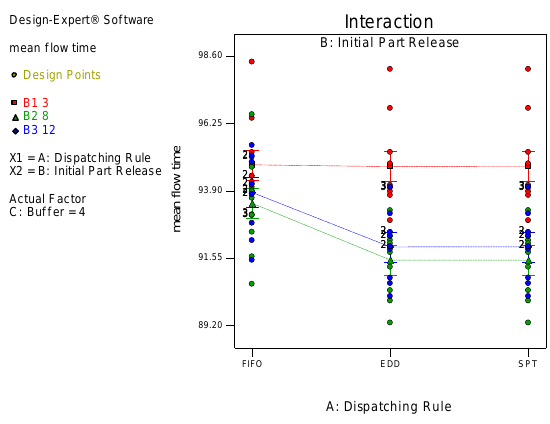
Figure 5. Average flow time, initial part release & dispatching rule